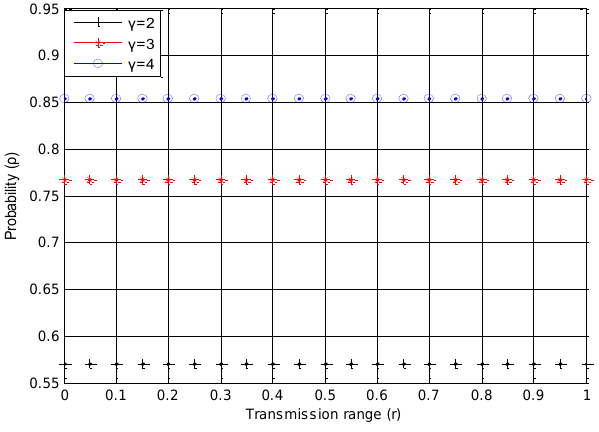
Figure 6. Relationship between r and ρ for γ .